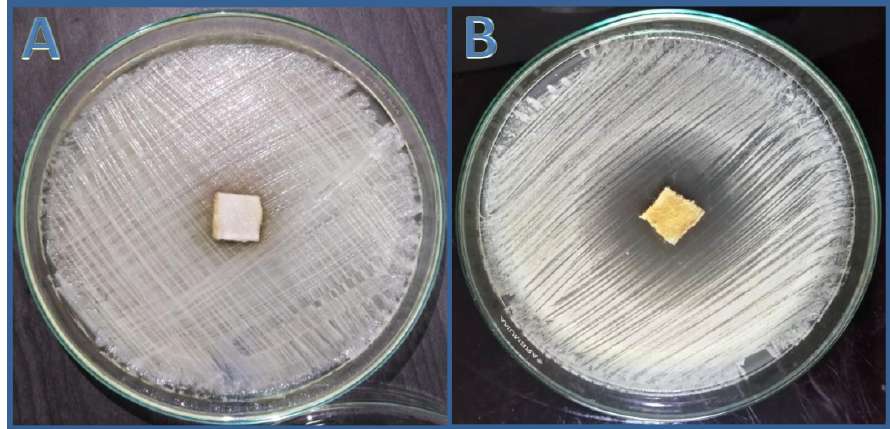
Figure 6. Anticandidal activity of untreated ( A ) and treated ( B ) cotton fabrics with n -hexane extract of S. costus against C. albicans (ATCC 10231) after 36